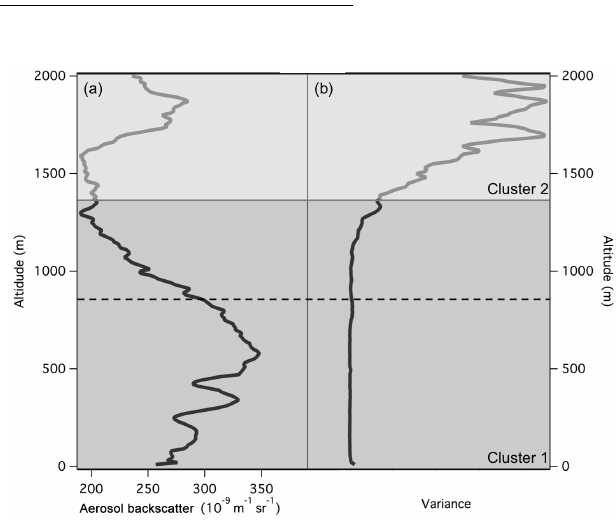
Figure 9. Aerosol backscatter profile (a) on 19 October 2013 at 14:00CST and corresponding calculated variance profile (b) show- ing division of cluster analysis and estimated BLH (1370m) at the transition from low to high variance. Radiosonde BLH is shown as a dashed line at